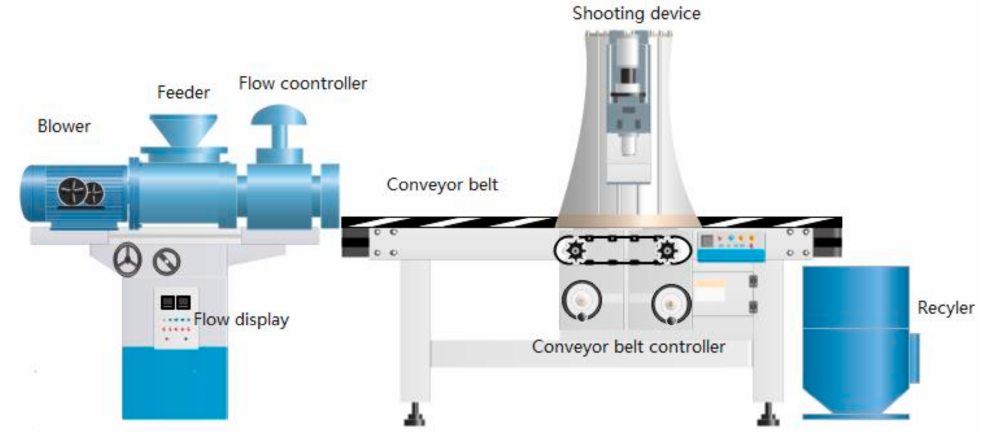
Figure 10. Design model of rapeseed pod testing